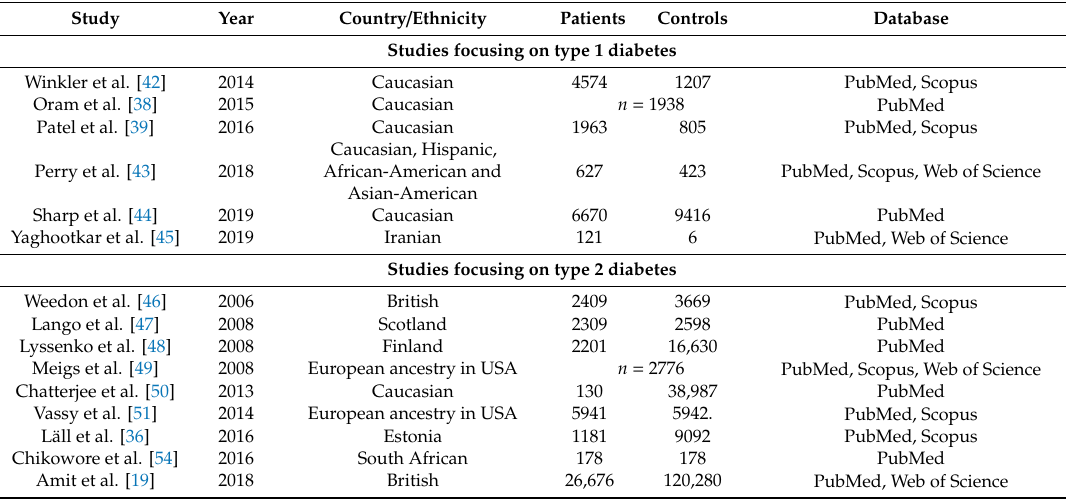
Table 1. The studies selected for the systematic